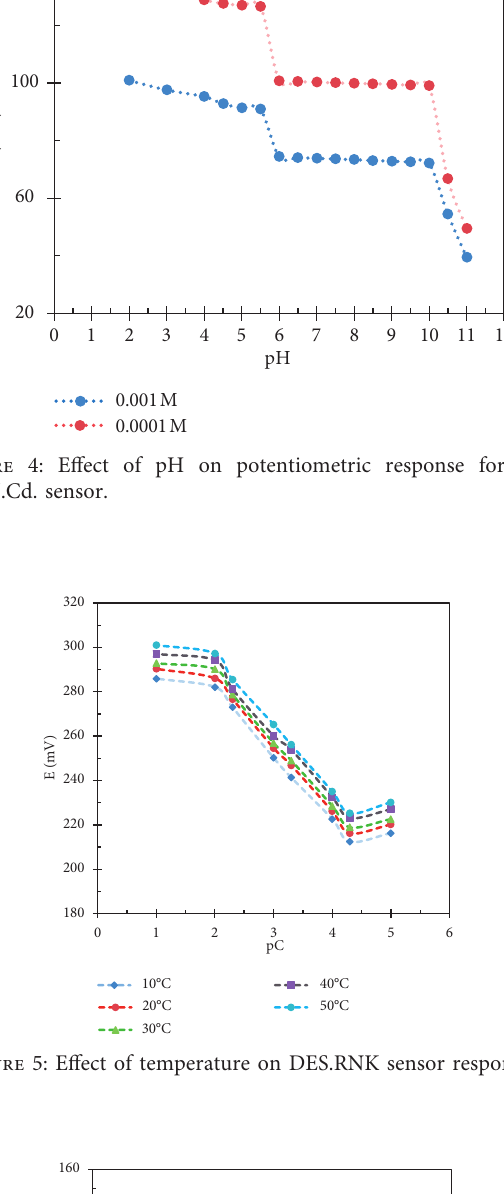
Table 3: Selectivity coefficients of DES- and MON-coated graphite sensors.